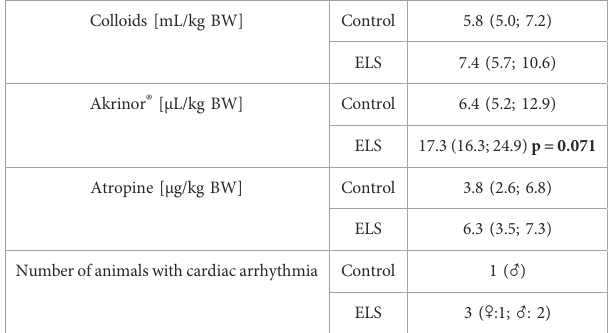
TABLE 2 Requirements for fl uid resuscitation and circulatory support in the control and Early Life Stress (ELS) groups (n = 6 each). “ Arrhythmia ” refers to the number of animals presenting with cardiac arrhythmia, i.e., ventricular extrasystoles and/or atrio-ventricular block II ° , Akrinor ® is a combined solution of theodrenaline/cafedrine 10/200 mg/mL; all data are median (interquartile range); the bold number refers to the p -value for intergroup comparison. Colloids [mL/kg BW]